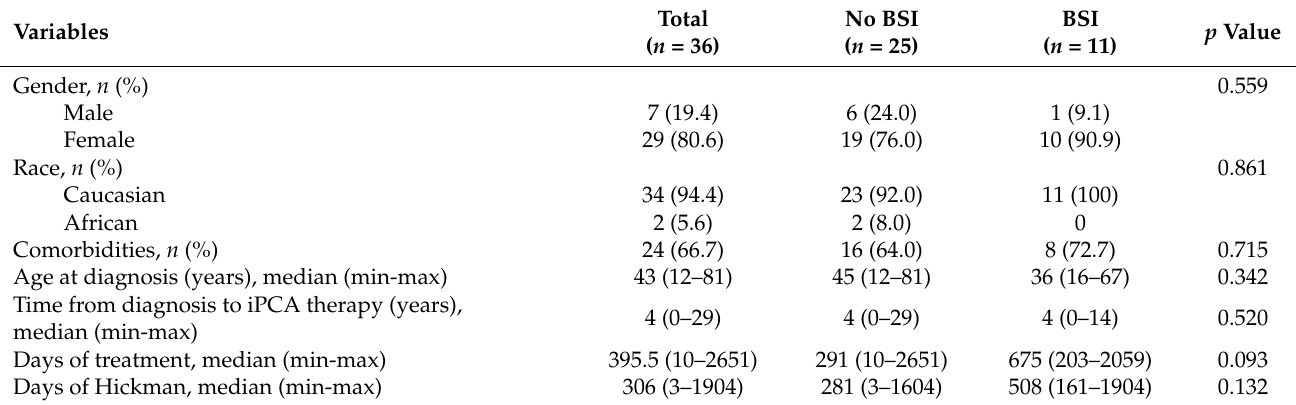
Table 4. Characterization of patients who developed BSIs ( n = 36).